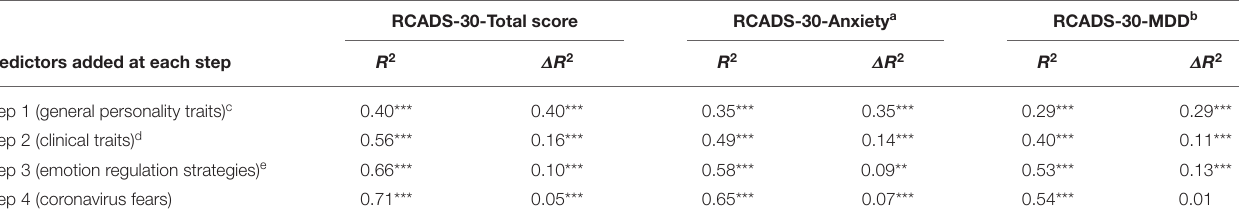
TABLE 3 | Hierarchical multiple regression analyses examining the role of transdiagnostic measures and coronavirus fears (incremental validity) in the prediction of anxiety and depressive disorder symptoms.